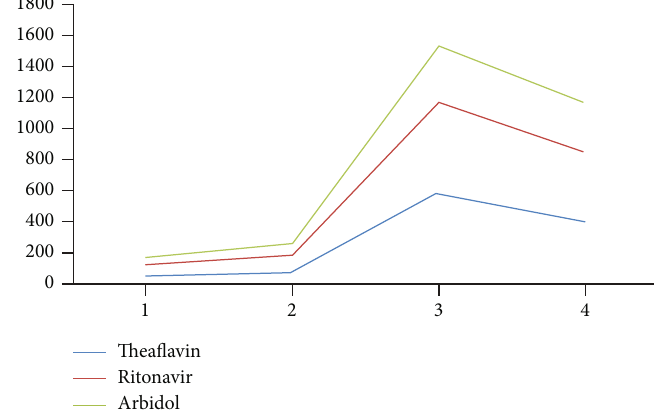
Figure 14: Comparison of thea fl avin, ritonavir, and